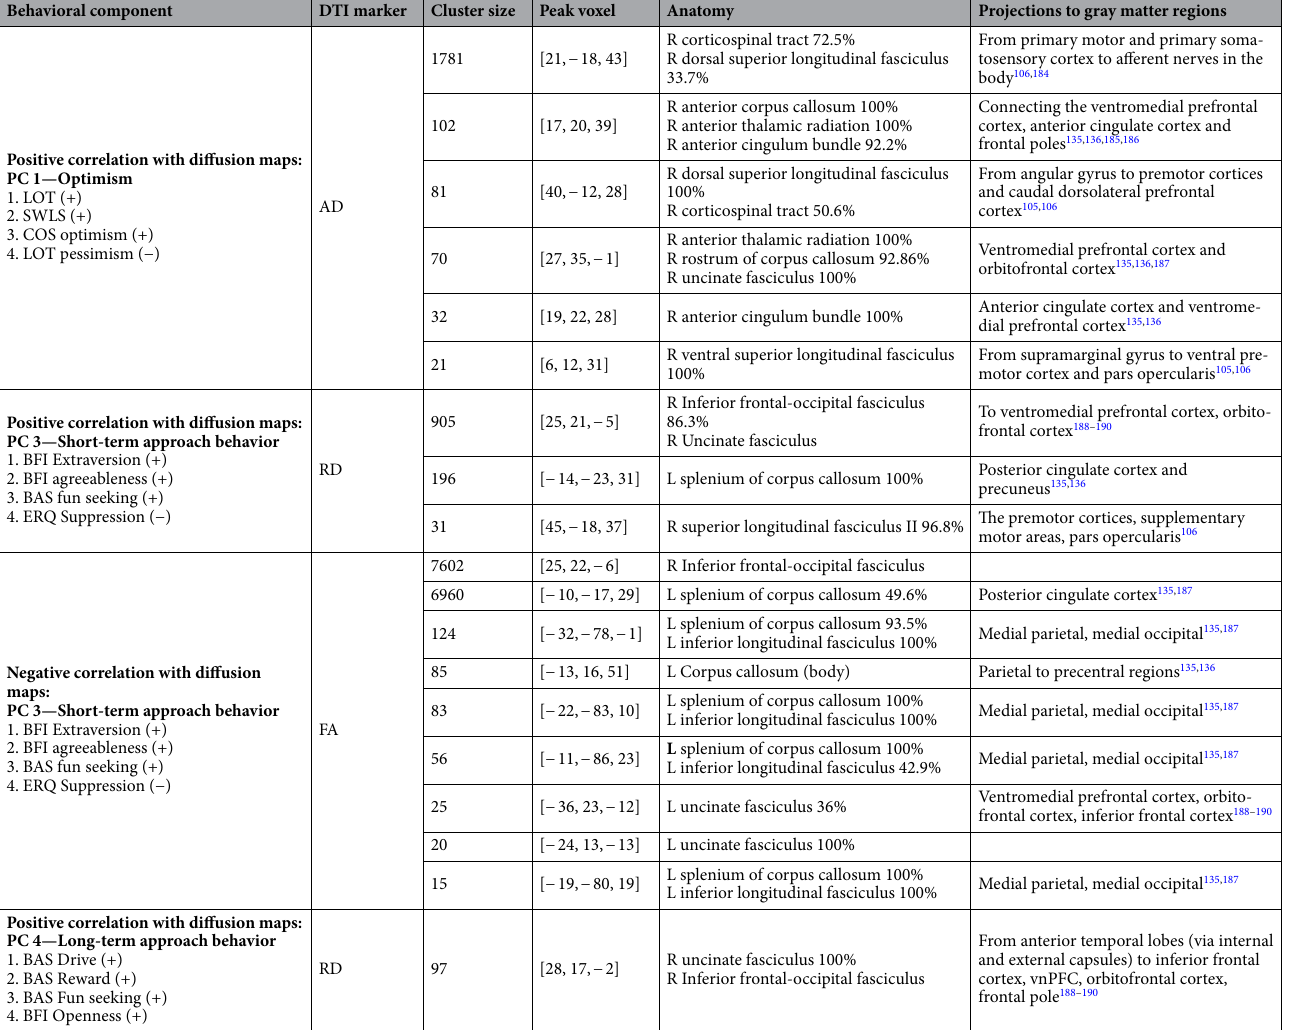
Table 2. TBSS randomized results with TFCE at p < .05 after 5000 permutations. The correlation results for behavior data with DTI maps for axial diffusivity (AD), radial diffusivity (RD) and fractional anisotropy (FA) are presented along with the cluster size, peak voxel coordinate and tract anatomy of the findings. LOT — Life LOT — Life Orientation Test. SWLS — Satisfaction With Life Scale. COS — Comparative Optimism Scale. BIS